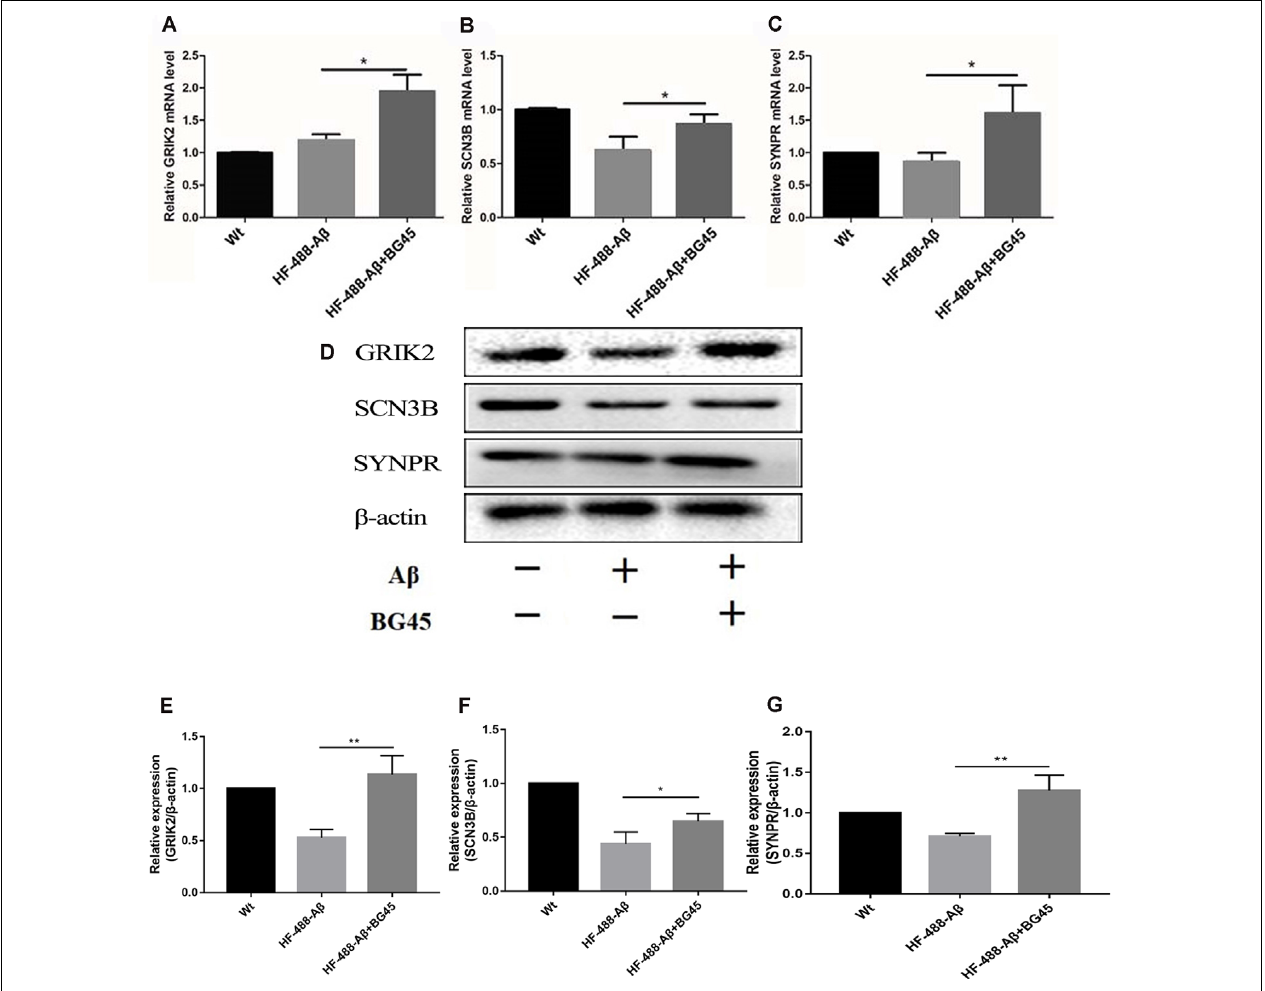
FIGURE 8 | The mRNA and protein levels of synaptic-related genes in the hippocampus after HF-488-A β treatment. (A) the mRNA levels of GRIK2; (B) the mRNA levels of SCN3B; (C) the mRNA levels of SYNPR. (D) Representative bands of the expression of GRIK2, SCN3B, and SYNPR from control mice, HF-488-A β group, and HF-488-A β + BG45 group. (E–G) Quantification of GRIK2, SCN3B, and SYNPR is normalized to β -actin and is shown as a % of control. Compared with the HF-488-A β group, the mRNA levels and their proteins of synaptic-related genes GRIK2, SCN3B, and SYNPR were upregulated in the HF-488-A β + BG45 group. n = 5. * p < 0.05, ** p <